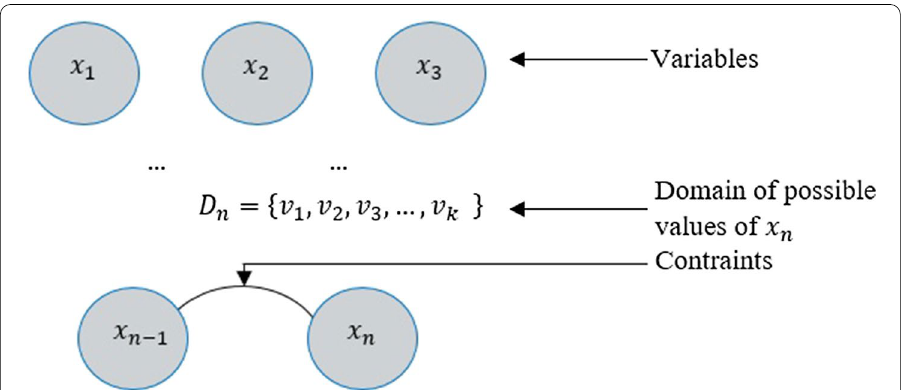
Fig. 3 Graphical representation of a constraint satisfaction problem. A constraint satisfaction problem is defined by a set of variables ( x i ), the corresponding set of domains ( D i ) of the possible values of each variable and a set of constraints ( C i